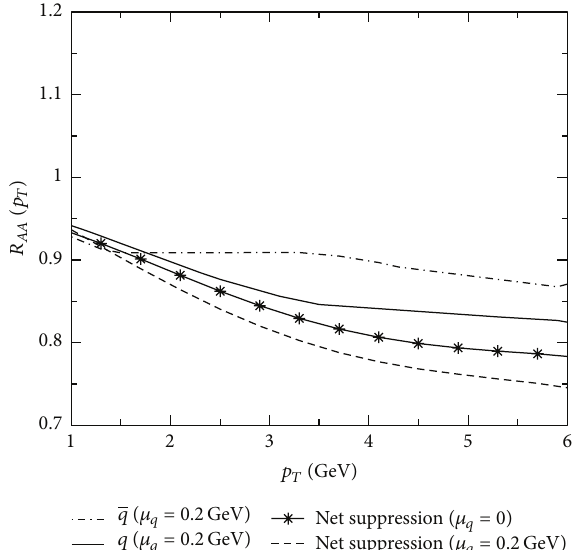
Figure 19: The same as Figure 18 with enhancement of cross section by a factor of